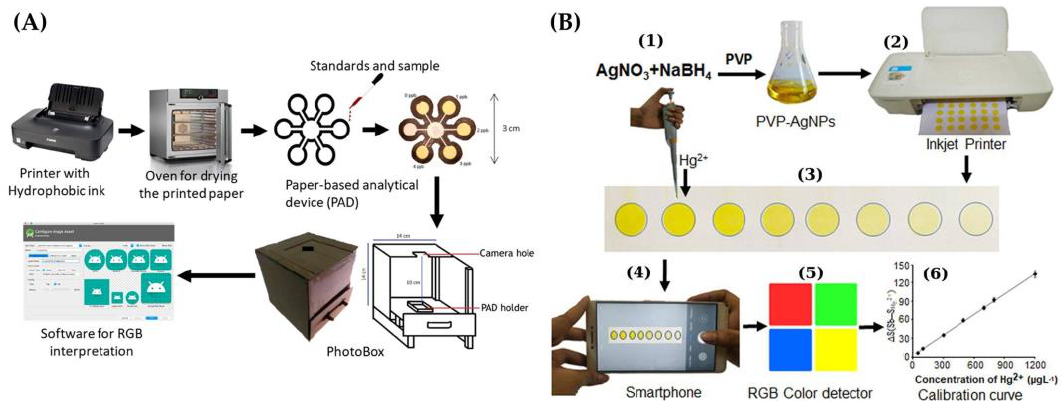
Figure 5. ( A ) Scheme of the PAD preparation and digital image acquisition for Hg detection using AgNPs as colorimetric probe [70]. ( B ) Scheme for inkjet-printing of PVP-AgNPs on paper; (1) synthesis of PVP-AgNPs; (2) Inkjet-printing on Whatman filter papers; (3) deposition of sample solution containing Hg(II) on the PAD; (4) image capture using a smartphone; (5) measurement of color intensity; (6) standard calibration curve [72]. Figure 5B is reproduced with permission of Elsevier [72].